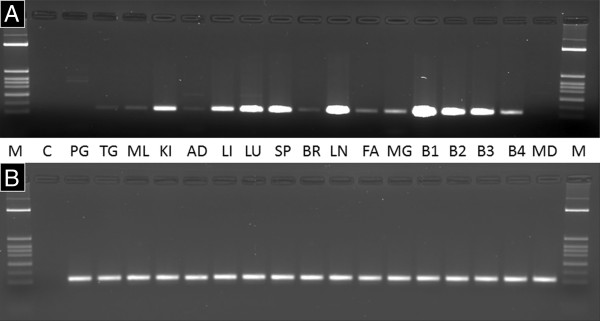
Expression of XLOC_032517 in blood and other bovine tissues. Detection of RT-PCR products from the XLOC_032517 locus (A) and the reference gene EIF3K (B) in cDNA from whole blood of cows, in bovine tissue samples and the MDBK cell line. M: Molecular weight marker, C: negative control without template, PG: pituitary gland, TG: thyroid gland, ML: skeletal muscle, KI: kidney, AD: adrenal gland, LI: liver, LU: lung, SP: spleen, BR: brain, LN: lymph node, FA: fat, MG: mammary gland, B1: blood sample from cow vaccinated with BVDV vaccine PregSure®, B2-B4: blood sample from cows vaccinated with an alternative BVDV vaccine, MD: MDBK cell line.